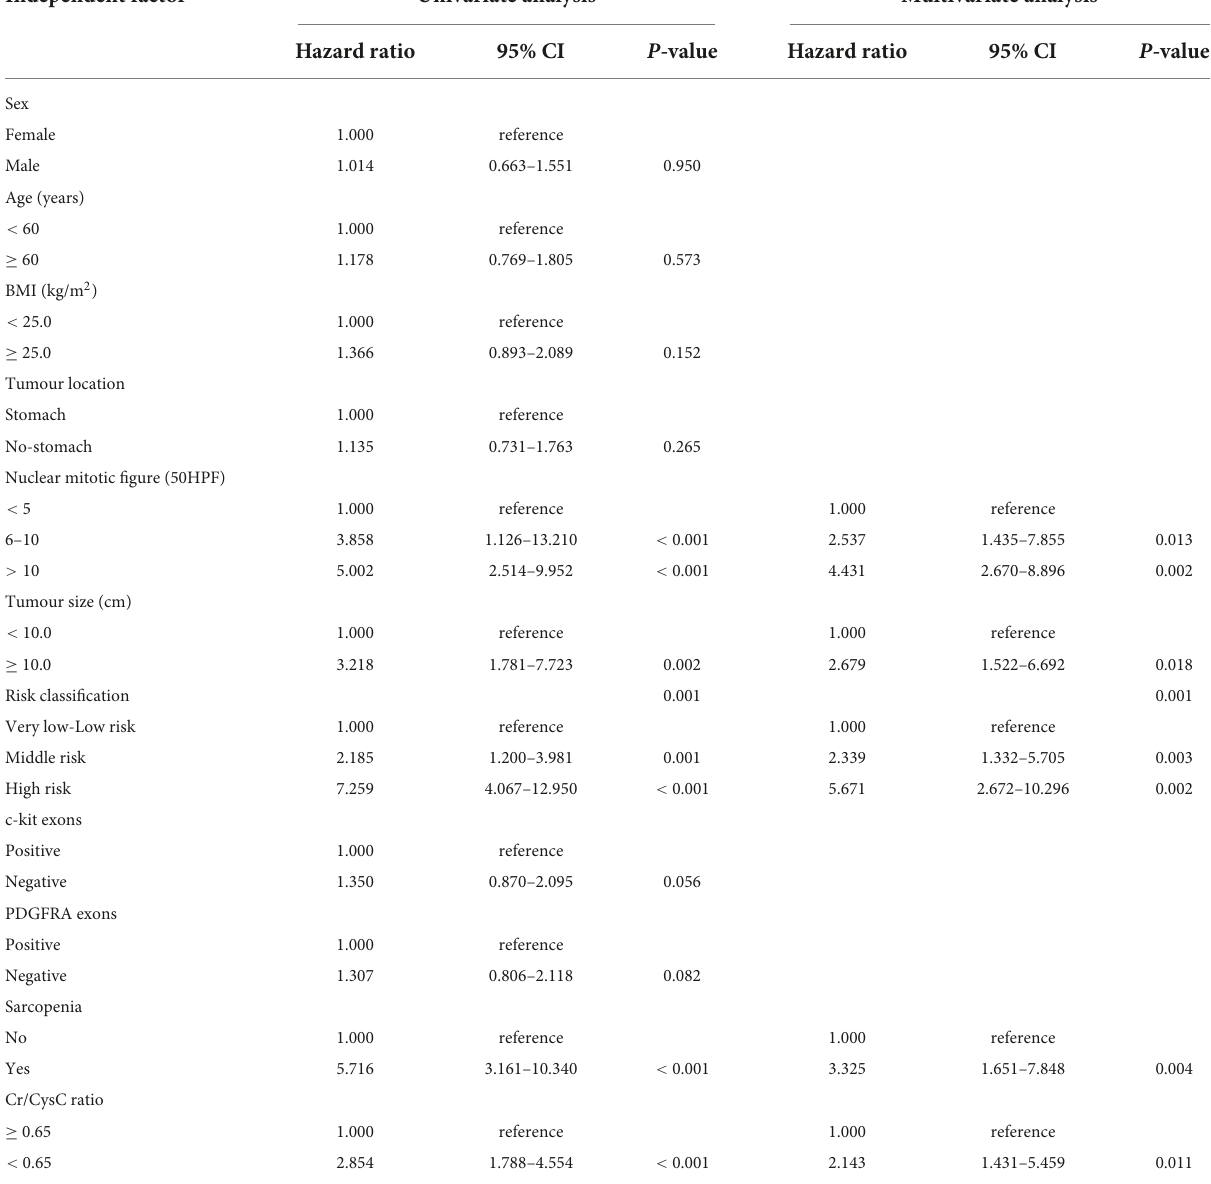
TABLE 5 Univariate and multivariate analyses of the clinicopathological characteristics for